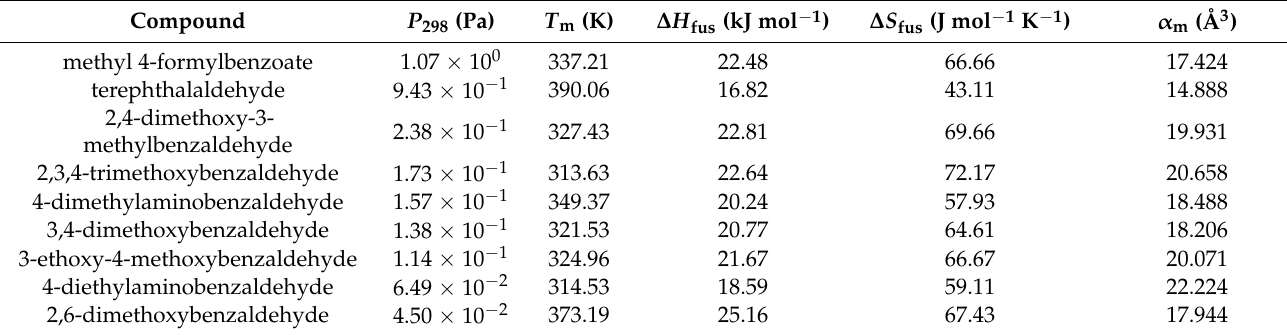
Table 4. P sat at 298 K, melting point, enthalpy of fusion, entropy of fusion and polarisability of the non H-bonding L benzaldehydes.